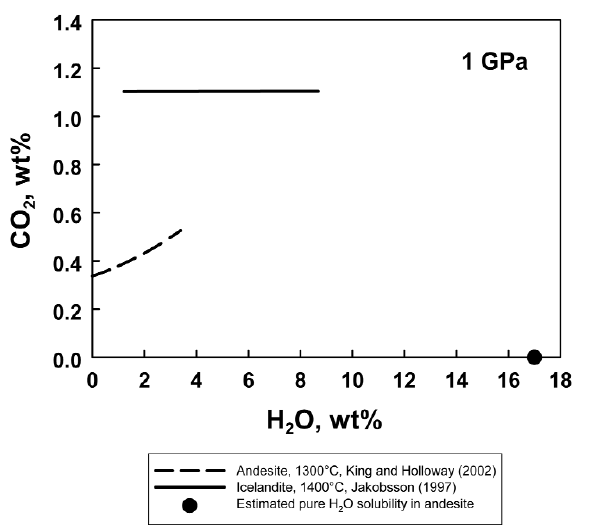
Fig. 6. Available experimental data on H 2 O-CO 2 solubility at 1 GPa for melt compositions close to andesite. Sol- id and dashed lines are the best fits of the data points obtained by Jakobsson (1997) at 1400°C for icelandite (54.5 wt% SiO 2 ) and by King and Holloway (2002) at 1300°C for andesite (59-60 wt% SiO 2 ). Remarkable is that the sol- is almost independent on H 2 O content of the melt (or on water activity), ubility of CO 2 in icelandite at low X f H 2 O which is similar to the observed solubility behavior of CO 2 in basaltic melt at 500 MPa and 1150°C (see fig. 640